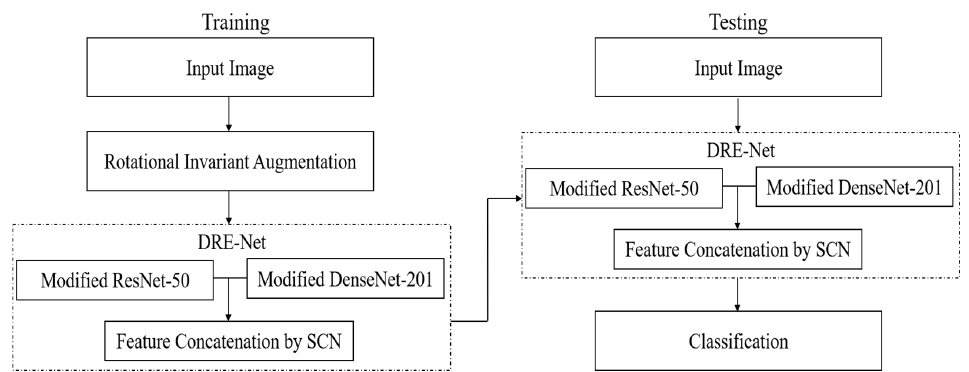
Figure 2. Overall procedure of the proposed method.